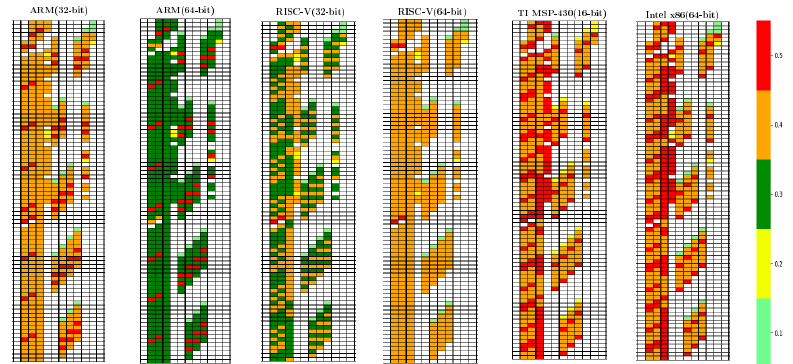
Figure 11: SuccessScore of vulnerable instruction from an AES(LookUp Table) based implementation on six different processors. Each cell represents an instruction and the color code represents the SuccessScore .